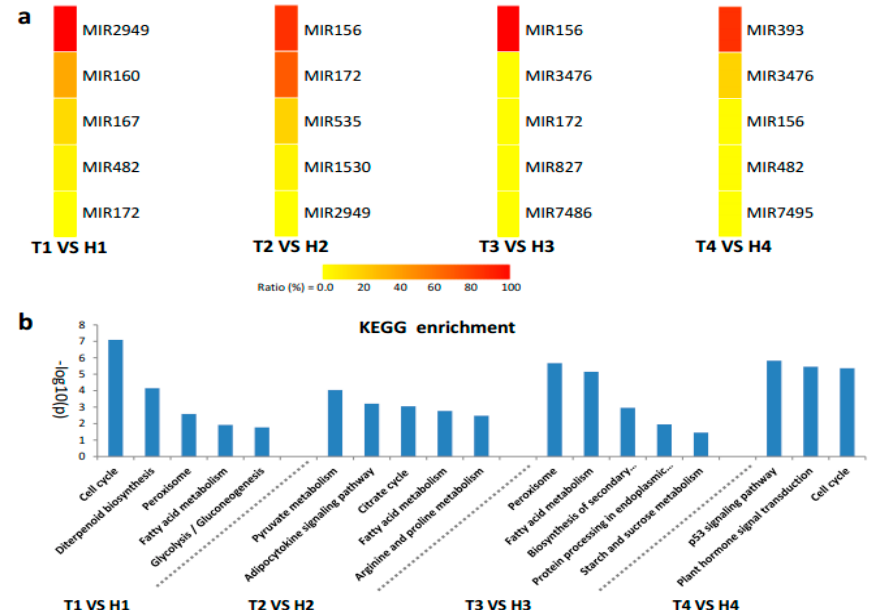
Figure 4. Heatmap of the expression abundance of differentially expressed miRNA families and Kyoto Encyclopedia of Genes and Genomes (KEGG) enrichment analysis of the predicted target genes. ( a ) The top five expression abundance rates of miRNA families responding to HT stress in the HT-tolerant and the HT-sensitive lines. The expression abundance rate is determined as the expression abundance (in percentage) of a miRNA family over the total expression abundance of miRNA families at a certain stage (sum of family member’s expression abundance/the sum of expression abundance of all differentially expressed miRNAs at a certain stage). ( b ) KEGG enrichment of target genes of miRNA families with high expression abundance.